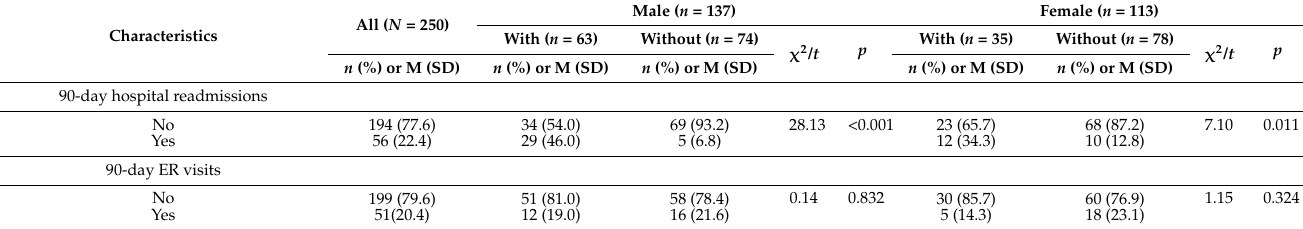
Table 2. 90-day hospital readmissions and emergency room (ER) visits by AF status in older patients with HF.